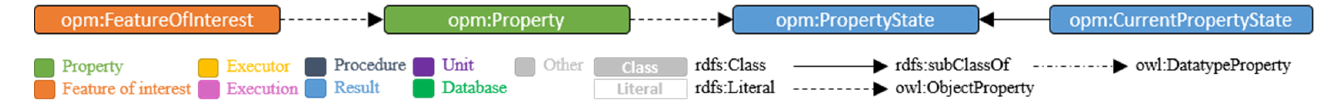
Figure 2. BIMDO describes properties using object properties and datatype properties.